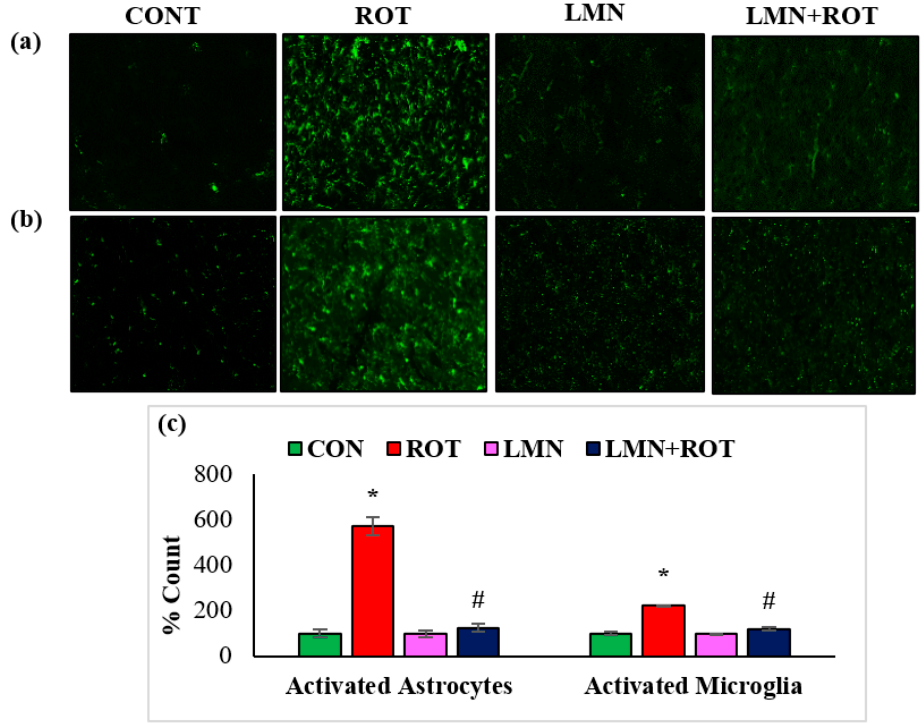
Figure 6. The activation of GFAP and Iba-1 in striatum was explored by immunofluorescence stain- ing of striatum. A remarkable expression of activated astrocytes (GFAP-positive) ( a ), and microglia (Iba-1-positive) ( b ), was indicated in the fluorescent images taken from ROT-injected rats when compared to the control rats. ( c ), The quantitative analysis of the number of activated astrocytes and microglia is shown. Each group consists of three rats and the values are presented as mean ± SEM; * p < 0.05 CON vs. ROT; # p < 0.05 ROT vs. LMN + ROT (one-way ANOVA followed by DMRT). CON: normal control, ROT: rotenone, LMN: limonene, LMN + ROT: limonene and rotenone treat- ment.